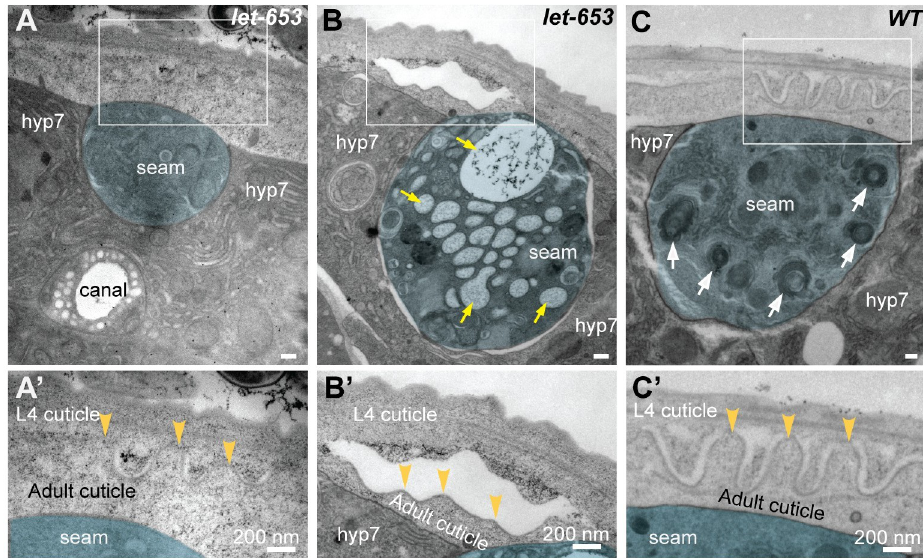
Fig 10. The provisional matrix component LET-653 is required for patterned adhesion versus separation of matrix layers. (A-C) TEM micrographs of let-653(cs178) (A,B, strain UP3342) or wild-type (C, N2) L4 specimens. Transverse cuts through the mid-body are shown. Seam cell is false-colored in blue. Scale bars: 200 nm. Boxed regions are shown at higher magnification in A’-C’. (A, A’) There is no clear distinction of adhesive vs . separated matrix regions in this mid-L4 let-653 specimen, despite the appearance of nascent alae ridges. (B, B’) Mis-shapen alae ridges have completely separated from the L4 cuticle of this late L4 let-653 specimen. Large vesicle structures (yellow arrows) also fill the seam cell, suggesting abnormal protein trafficking, We previously reported an accumulation of unusually large vesicles in vulF vulva cells of this same specimen [53]. (C, C’) Many lysosomes or related lamellar organelles (white arrows) appear within the seam cell in wild-type late L4 specimens (N =